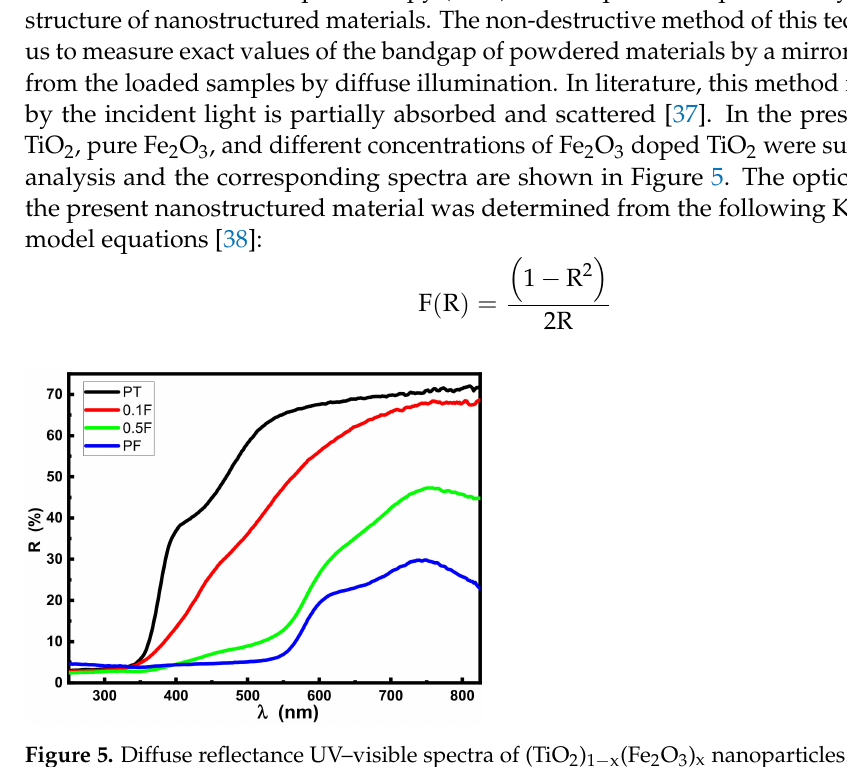
Figure 5. Diffuse reflectance UV–visible spectra of (TiO 2 ) 1 − x (Fe 2 O 3 ) x